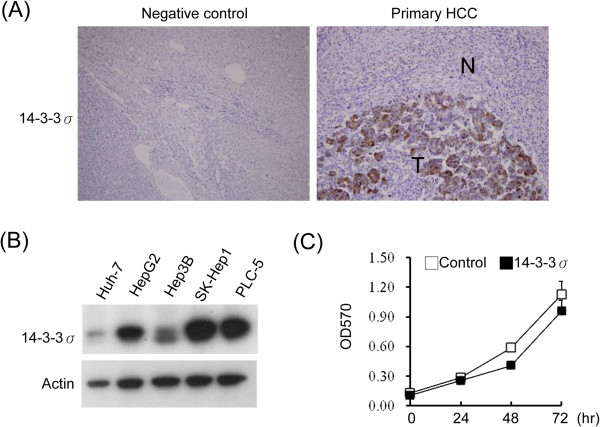
14-3-3σ overexpression induces tumor growth. (A) A represtative expression of 14-3-3σ in a primary HCC tumor and in a negative control examined by immunohistochemical analysis. T: tumor; N: non-cancerous cells. Original magnification: ×200. (B) 14-3-3σ expression levels in HCC cell lines were determined by Western blot analysis. Actin was used as a loading control. (C) The rate of cell proliferation was determined by an MTT assay. Scale bars: mean ± SD.